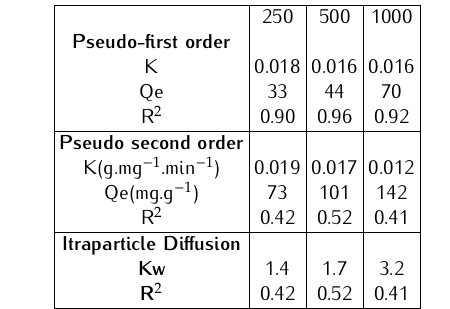
Table 2. Valuesofthecalculatedconstantsindifferentkineticsmodel